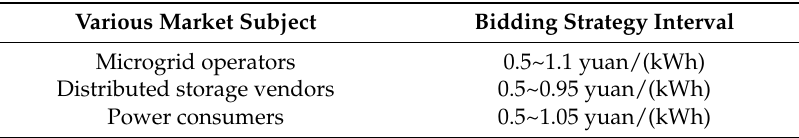
Table 1. Bidding strategy interval for each type of market subject